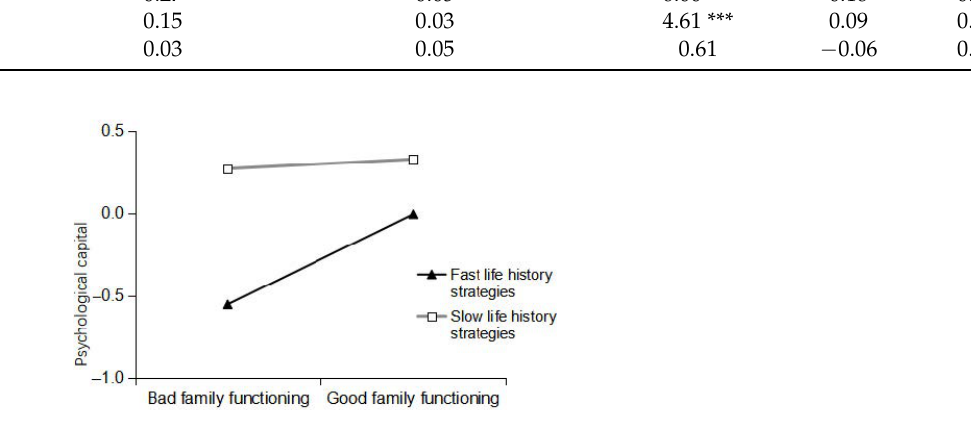
Figure 2. Diagram of the moderating effect of life history strategies on the relationship between family functioning and psychological